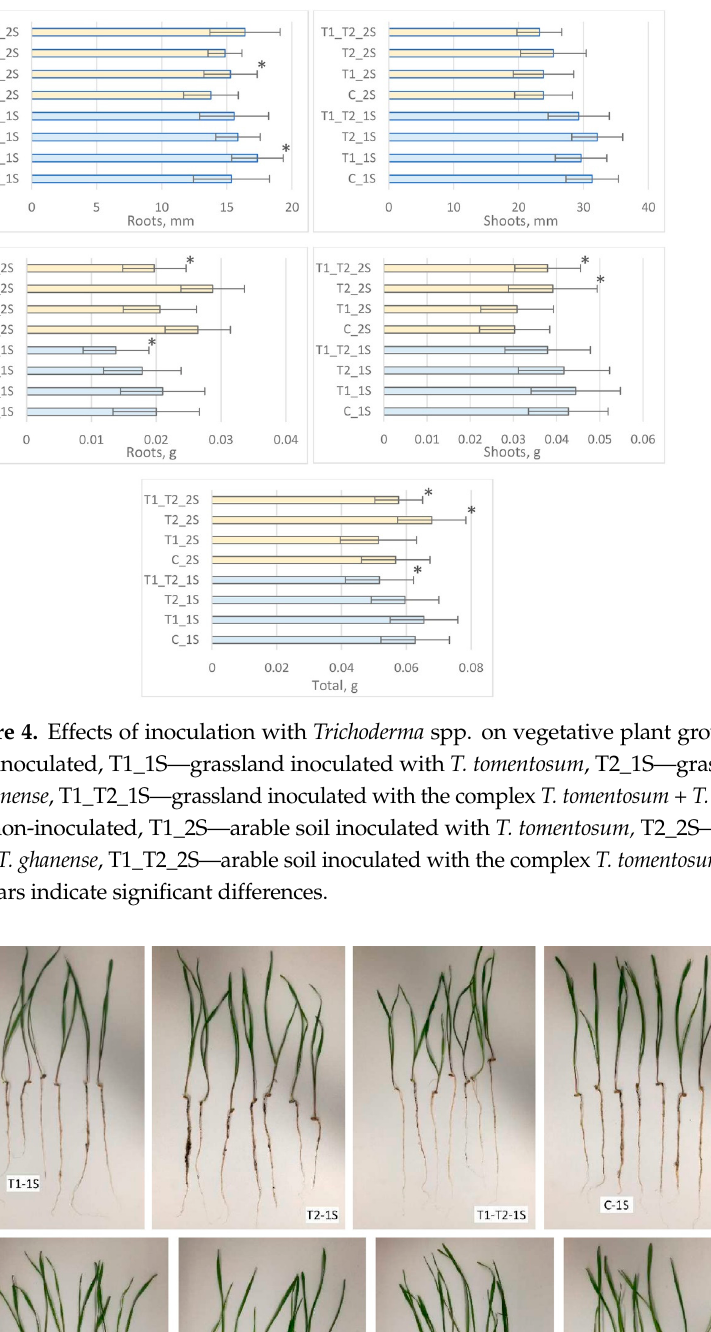
As shown in Figure 4, the plant growth promotion ability of T. ghanense was detected in arable soil 2S. The total weight of rye seedlings was 19.3% larger in this variant com- pared to that of the control (significant differences p = 0.014). Differences in the length of shoots and roots between inoculated samples and the control were uncertain (no signifi- cant differences were observed p = 0.241 and p = 0.143, respectively) when T. ghanense was applied. The use of inoculum of complex T. tomentosum + T. ghanense in grassland 1S and ara- ble soil 2S did not have a growth promotion effect on the rye seedlings (Figure 4). The total weight of the rye seedlings was less in grassland 1S compared to the control, and a significant difference was observed ( p = 0.040). A statistically significant difference was established in arable soil 2S: the shoots were larger in weight ( p = 0.004) 4. Discussion The successful and efficient use of bioproducts for plant growth promotion depends on the active development of fungi in the substrates. Abiotic factors, as well as biotic, could promote or suppress the action of fungi in the soil. Therefore, the physiological characteristics of fungi and their ability to survive and adapt to various environmental conditions are of great interest. Muniappan and Muthukumar [45] observed the im- portance of pH values and detected a negative correlation between Trichoderma koningii abundance and soil pH. Moreover, Caporale et al. [25] demonstrated the importance of soil quality to the effect of different Trichoderma strains on Brassica rapa growth. Our studied fungi had different optimum growth conditions and enzymatic activity. It was observed that T. tomentosum could develop better at lower temperatures than T. ghanense, but the latter showed optimal growth under a broader range of pH. Moreover,